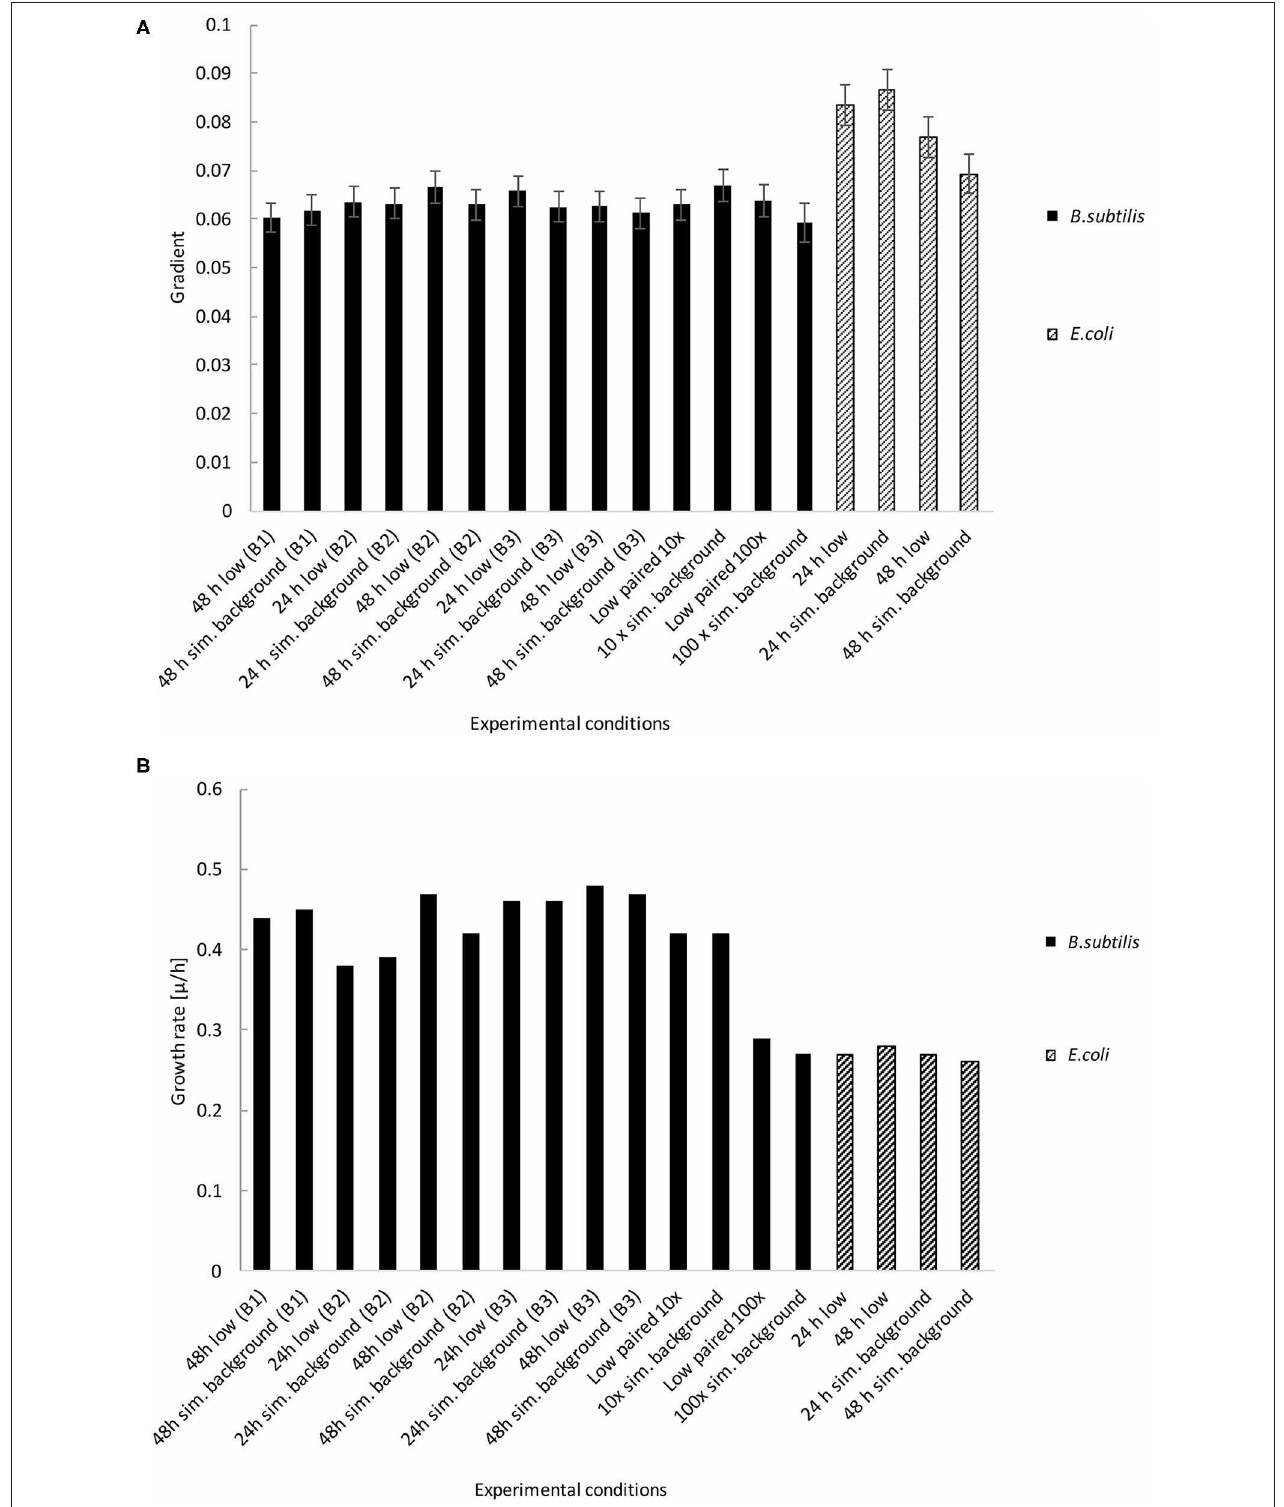
FIGURE 5 | Growth gradients and rates of B. subtilis and E. coli linear exponential growth phases at the determined low radiation (“low”) and artificial background radiation (“sim. background”) dose rate: 24 and 48h denote time in hours that bacteria batch has spent in respective conditions; B1-3 denote week number when the multiple B. subtilis samples were run; 10 × = 10 × the artificial background dose rate; 100 × = 100 × the artificial background dose rate; Low paired = low dose rate samples run parallel to 10 × and 100 × dose rates. Error bars show ± error of gradient. “B.s” and “E.c.” stand for B. subtilis and E. coli , respectively. (A) Growth gradients of B. subtilis and E. coli from the linear exponential growth phase. (B) Growth rates of B. subtilis and E. coli from the linear exponential growth phase.